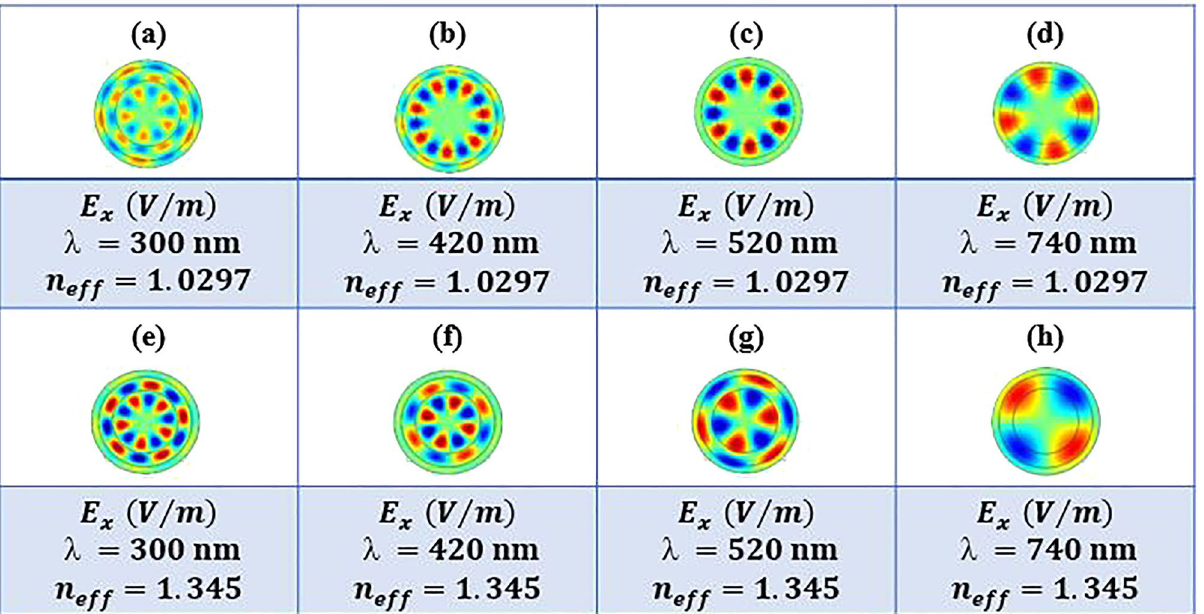
Figure 7. Electric field component E x of nerve fiber at 300 nm, 420 nm, 520 nm, and 740 nm wavelengths for different effective RIs, while light is launched to the myelin sheath.